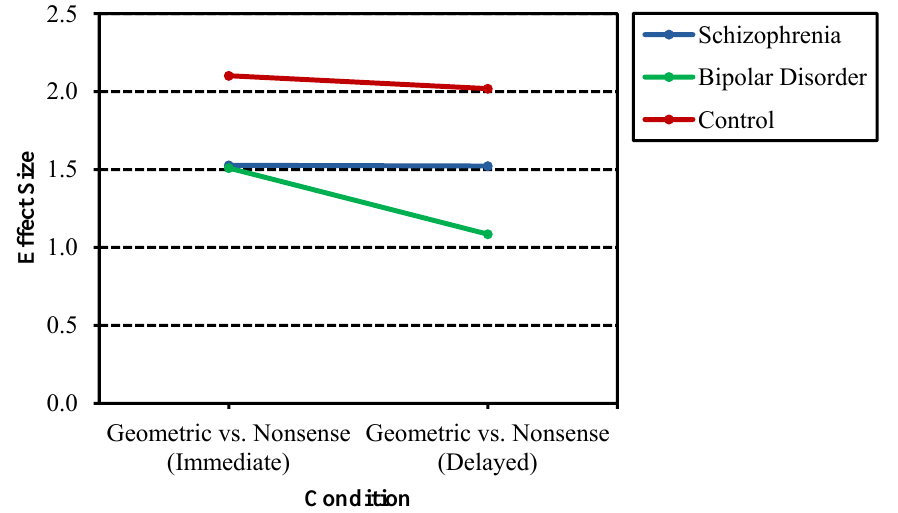
Figure 4. Effect sizes of d' differences between geometric designs and nonsense designs across proband groups and nonpsychiatric controls. Schizophrenia probands showed less benefit than psychiatric controls from namable geometric structures regardless of condition. Bipolar probands also showed less benefit from namable geometric structures in both conditions, but additionally demonstrated greater loss in benefit after a delay as compared to the other